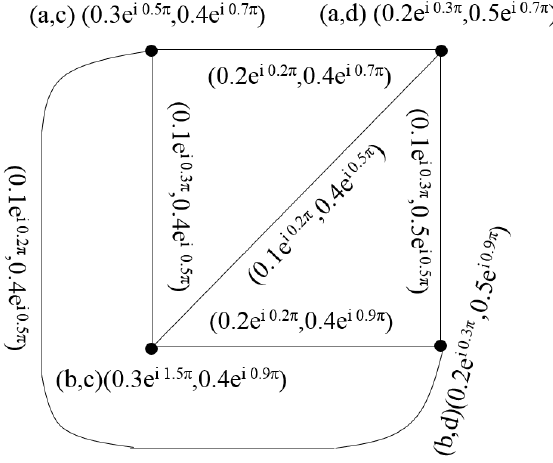
Figure 6. Complex intuitionistic fuzzy graph of G 1 ◦ G 2